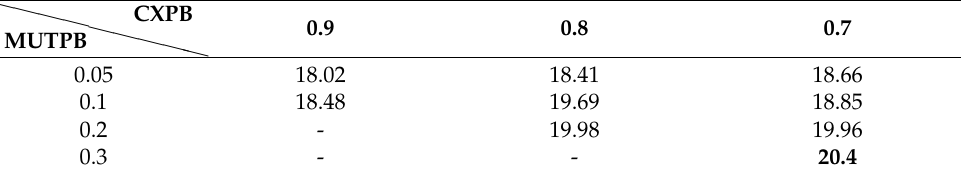
Table 4. Maximum reward result of the parametrization in the EA. In bold, the best values between both algorithms.